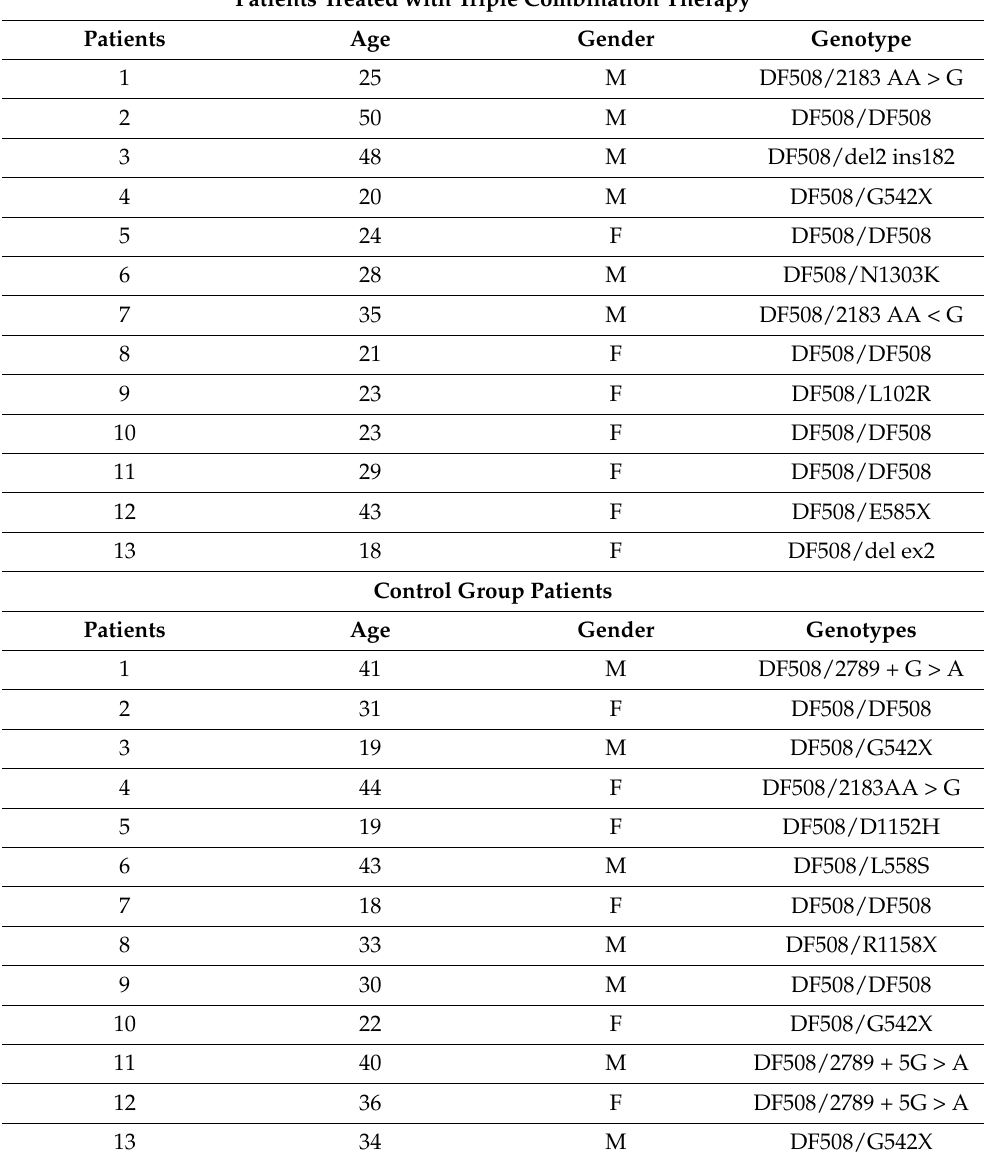
Table 5. General information about the two groups. Patients Treated with Triple Combination Therapy Patients Age Gender